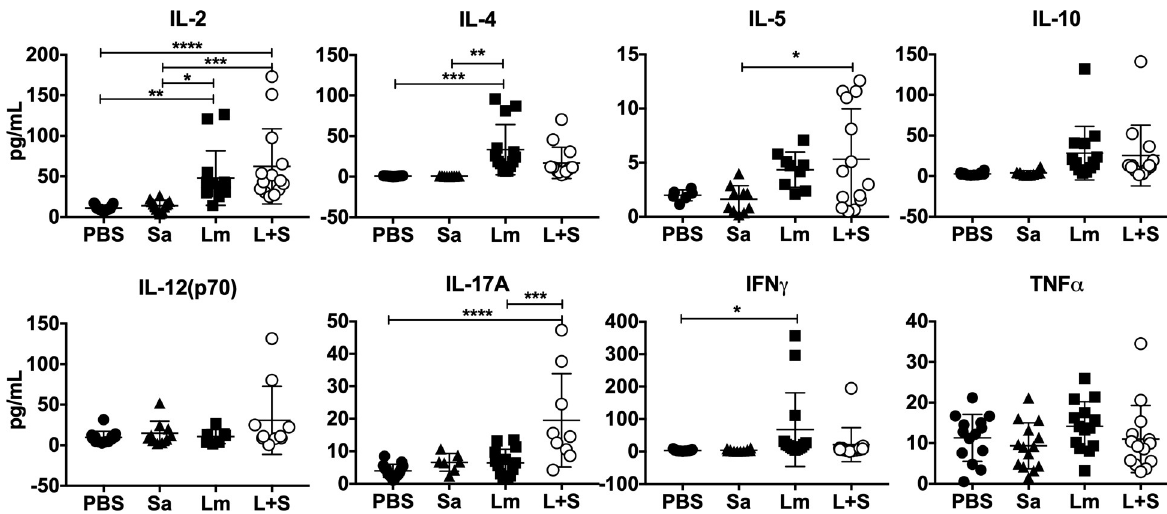
Fig 4. Immune cells from L . major - S . aureus coinfected mice produce similar levels of Th1- and Th2-type cytokines, but more IL-17A than singly infected mice in response to L . major antigen. Draining lymph nodes from mice day 28 p.i. were re-stimulated with live L . major promastigote antigen for 72 hours and cytokine levels in culture supernatants were assayed by multiplex ELISA. Data represent the mean ± SEM of three replicate experiments, each with 4–5 mice/group. � p < 0.05, �� p < 0.01, ��� p < 0.001, ���� p < 0.0001, ns = not significant by one-way ANOVA with Tukey’s post-test. PBS = phosphate buffered saline, Sa = S . aureus , Lm = L . major , L+S = L . major + S . aureus